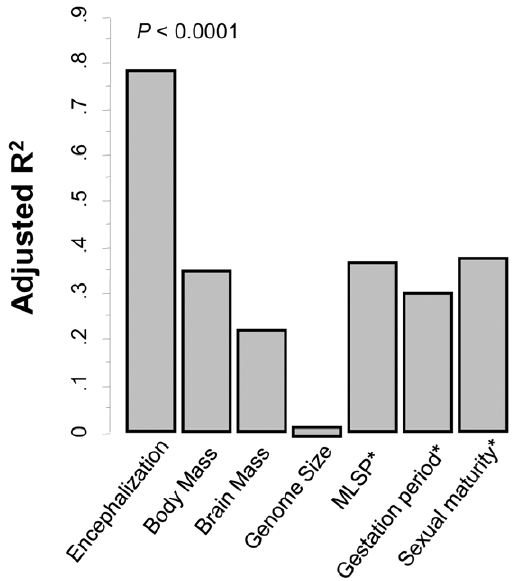
Figure 1. Overall protein AA frequencies correlate with encephalization. Chart showing Adj.R 2 values derived from multiple regressions including all 20 genomic AA frequencies per species as predictors of either encephalization index, brain mass, body mass, genome size, maximum life span (MLSP) gestational period or age of sexual maturity as predicted variables. Significance was numerically confirmed by a regression analyses against 10, 000 permutations of each of the above dependent variables. * Log-transformed values.